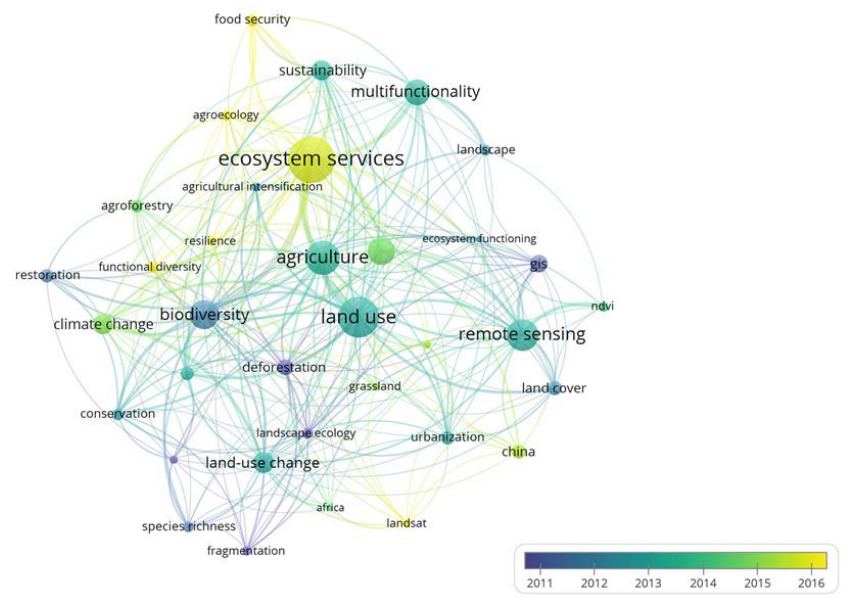
Figure 8. Network visualization of co-occurrence of author keywords in agricultural land function from 1991 to 2021 (node color is determined by the average use of each keyword). In addition, this paper derived co-occurrence information of authors ’ keywords from